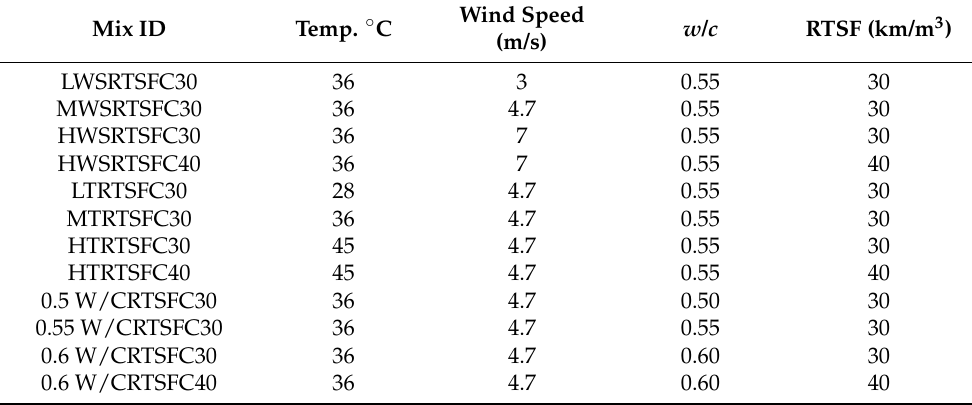
Table 1. Parameters of the